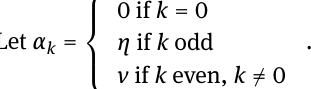
(cid:1) with G the filtration generated by (cid:16) B 1 , ˜ B h , B 2 (cid:17) . − B 2 ≥ z | G s t t